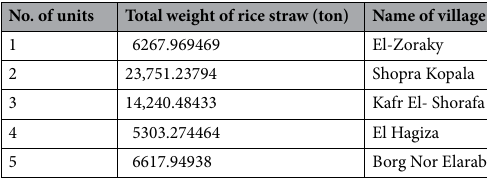
Table 2. The five sites in Sinbilawin